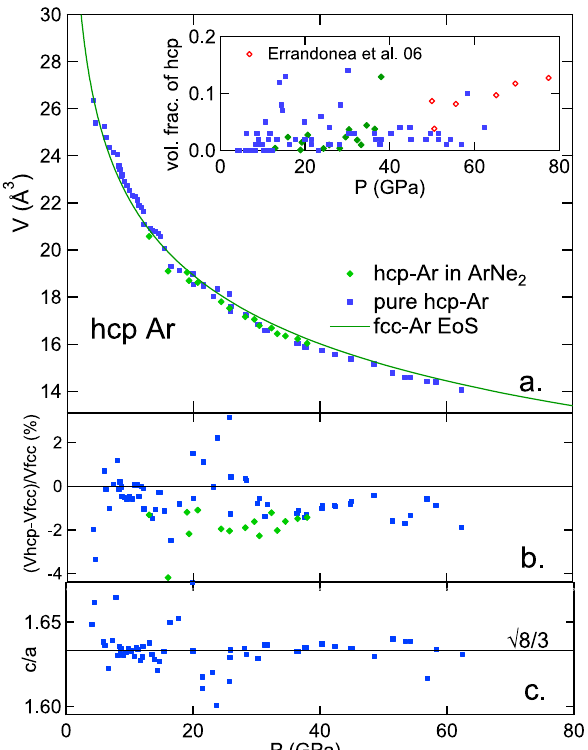
Figure 10. Equation of state of hcp-Ar. ( a ) Atomic volume vs pressure measured with Au standard 28 , compared with fcc EoS (see Fig. 9). Inset: volumetric fraction of hcp-Ar in argon ( V hcp /( V fcc Rietvelt analysis of XRD spectra. ( b ) Relative difference between atomic volumes of fcc and hcp Ar measured on the same XRD spectrum. ( c ) c / a lattice parameters ratio; the horizontal line indicates the ideal ratio for hexagonal close